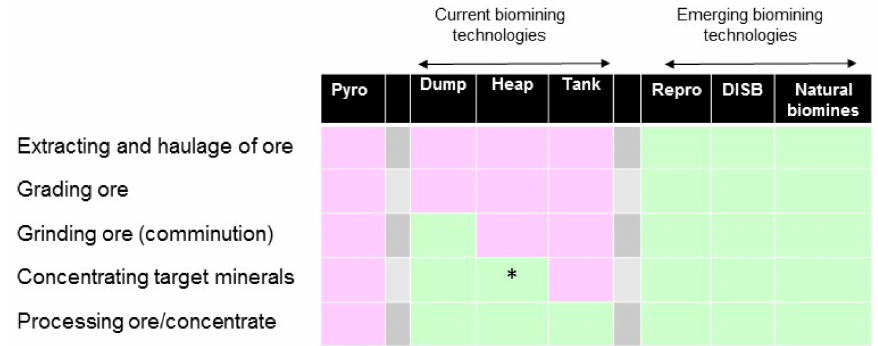
Figure 1. The comparison of the stages involved in conventional metal mining, and current and biomining technologies. The light purple shading indicates where these are necessary and light green shading where they are not. Abbreviations: “pyro” = pyrometallurgy; “repro” = reprocessing solid wastes; DISB = deep in situ biomining. * heap leaching sometimes uses crushed ores but other time mineral